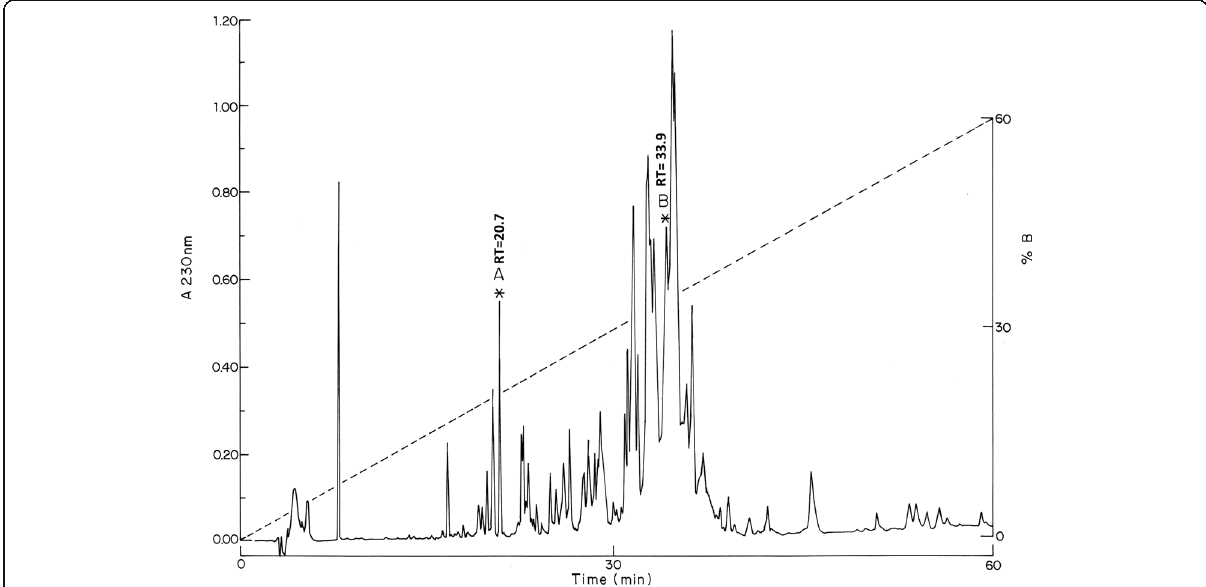
Fig. 1 Separation by HPLC of the venom of Centruroides hirsutipalpus . The soluble part of scorpion venom (0.75 mg of protein) was passed through a reverse phase C18 column and separated with a linear gradient of a solvent A (0.12% trifluoroacetic acid in water) to 60% of solvent B (0.10% TFA in acetonitrile), for 60